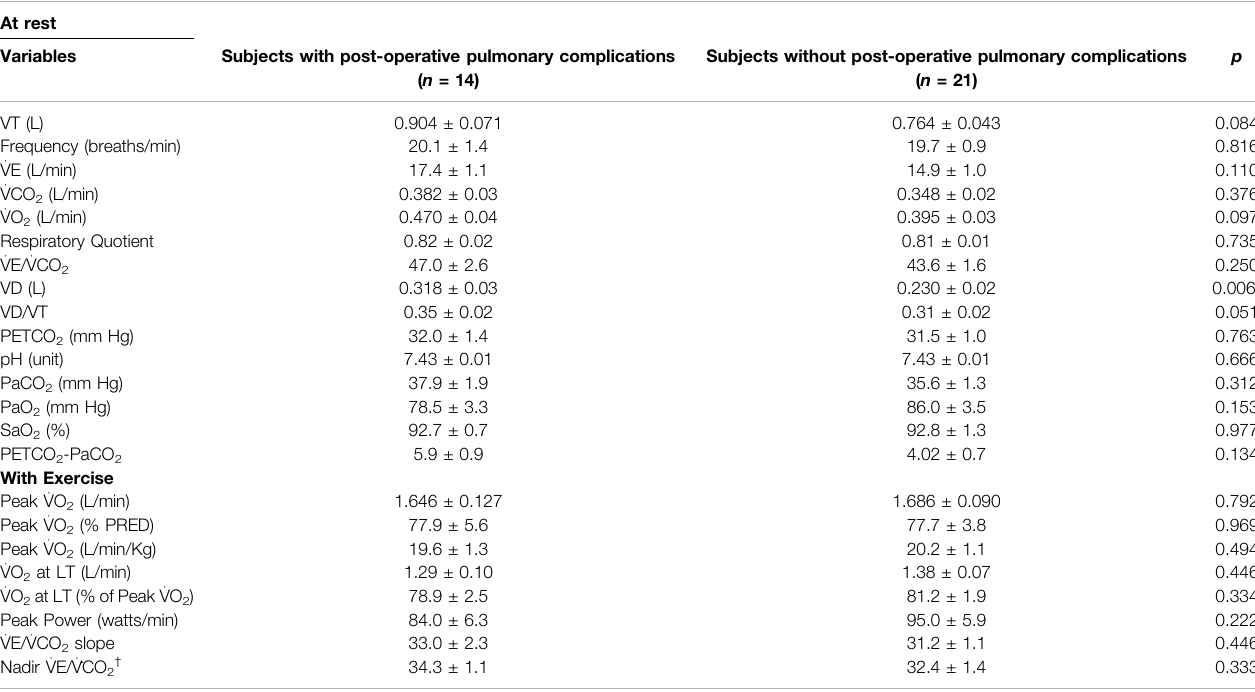
TABLE 3 | Cardiopulmonary exercise test at rest and exercise. At rest